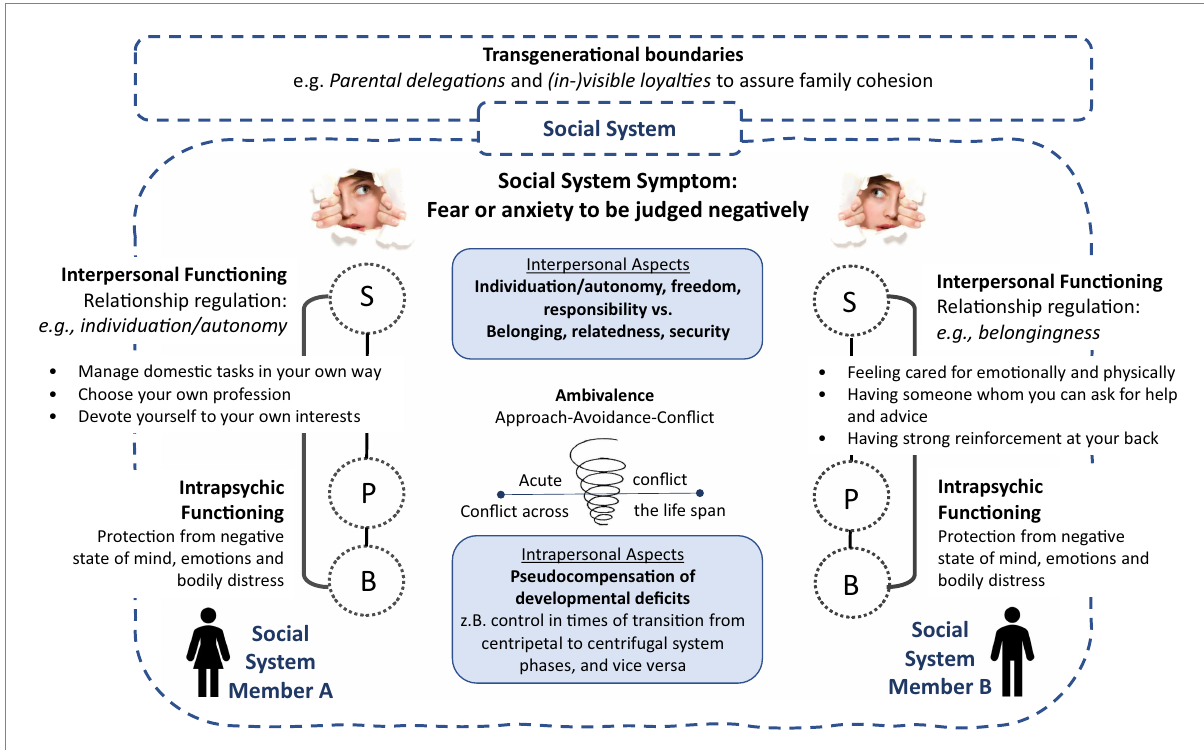
FIGURE 1 Socio-psycho-biological explanatory model adapted to social anxiety (Luhmann, 2017; Hunger et al., 2018; Schweitzer et al., 2020). S, Social system (verbal and non-verbal communication and interaction); P, Psychological system (thoughts, emotions); and B, Biological system (corporeal